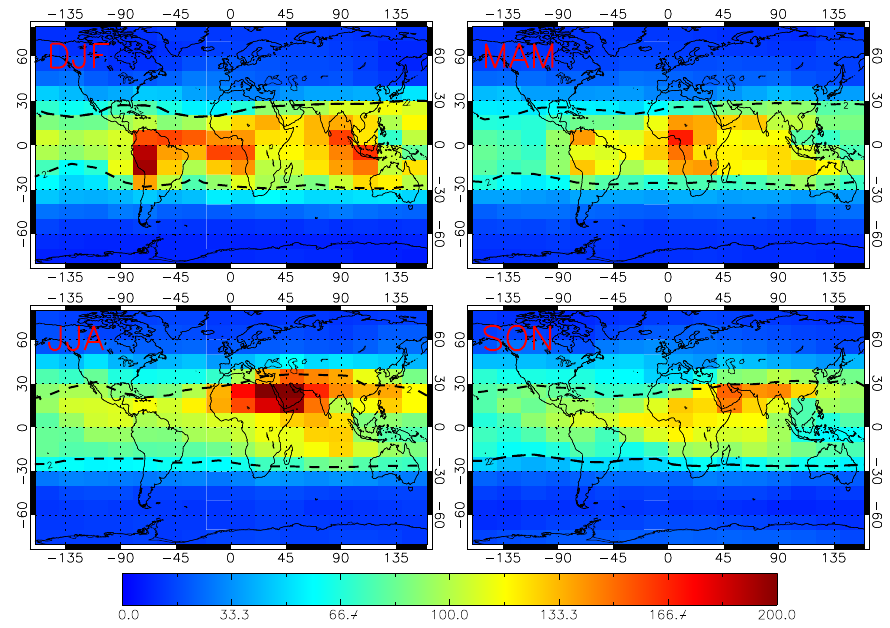
Figure 10. Mixing ratio of PAN (pptv) from the TOMCAT model (with the IMK averaging kernels applied) at 150hPa averaged over the periods DJF, MAM, JJA, and SON in 2007–2008.